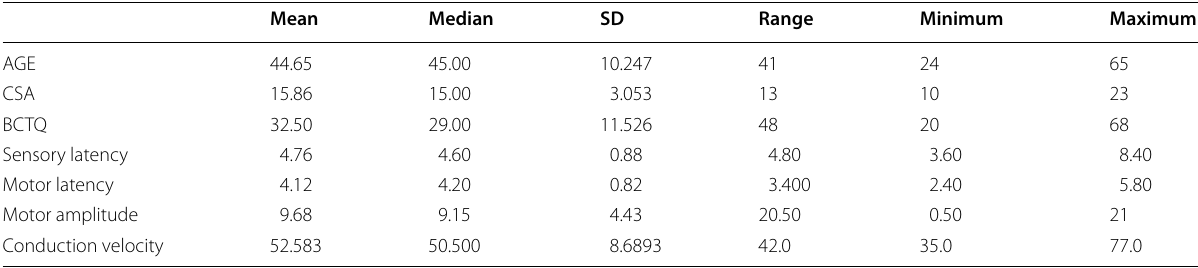
Table 1 Descriptive of subjects with abnormal BCTQ and neurophysiological studies (No.